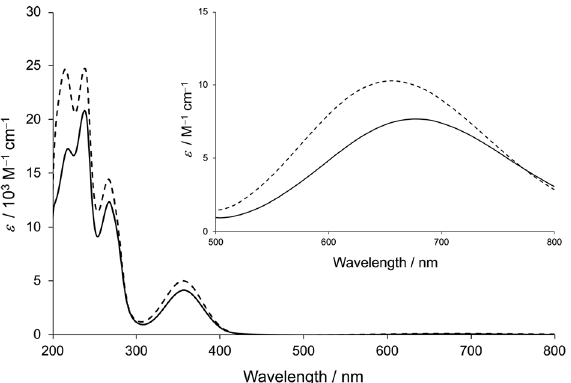
Figure 3. UV–vis spectra of CuST (0.1 mM, bold line) and CuST-Imi (0.1 mM, dashed line). Both spectra were measured in 0.1 M phosphate buffer (pH 7.0). Inset: expanded spectra in 500–800 nm region (1.0